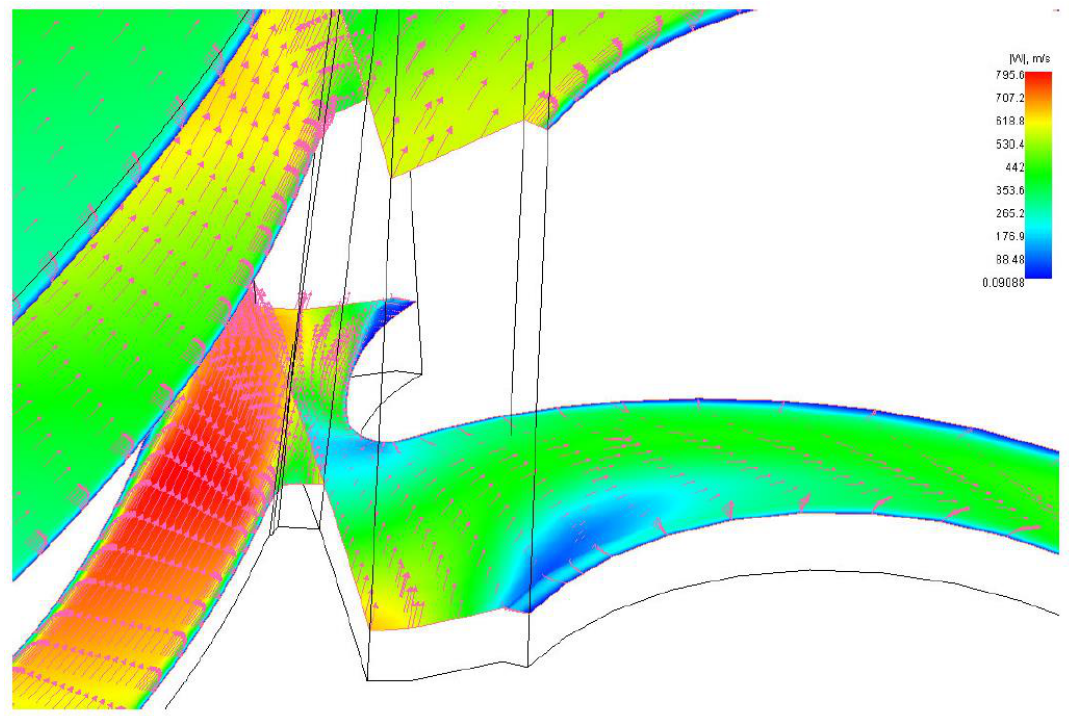
Figure 37. Velocity and velocity vector details of the hub section of the rotor highlight the separation bubble.